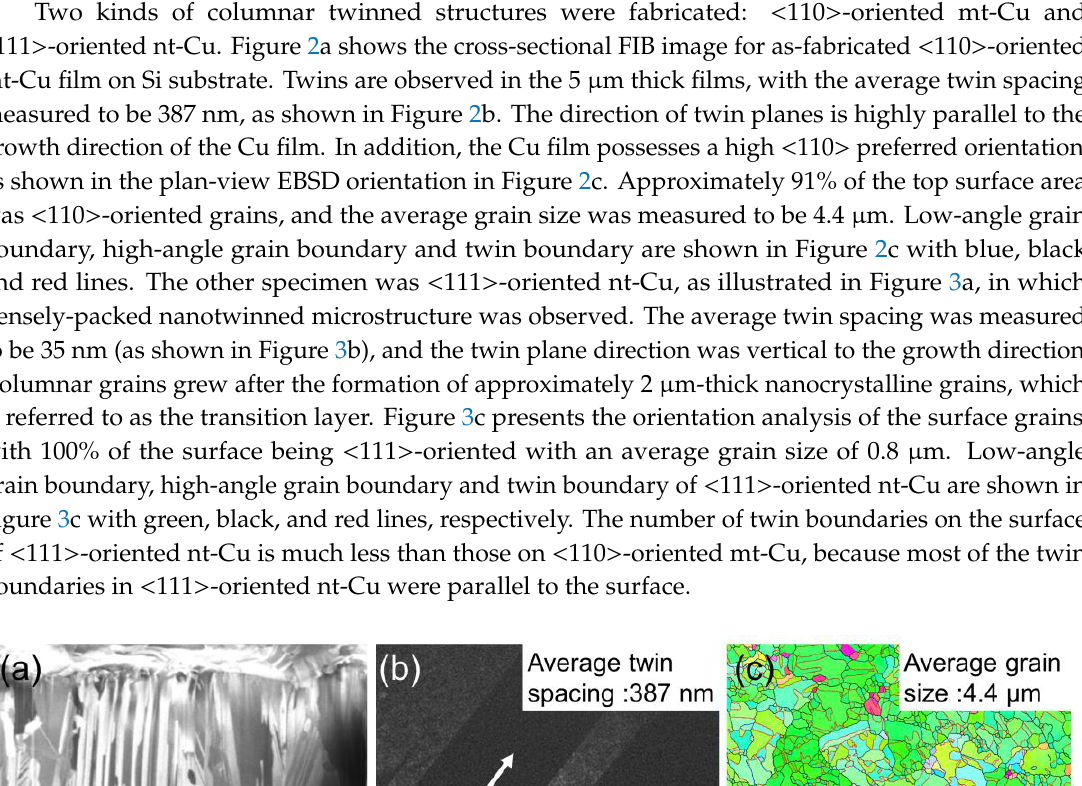
Figure 1. The schematic figure of the tensile specimen.